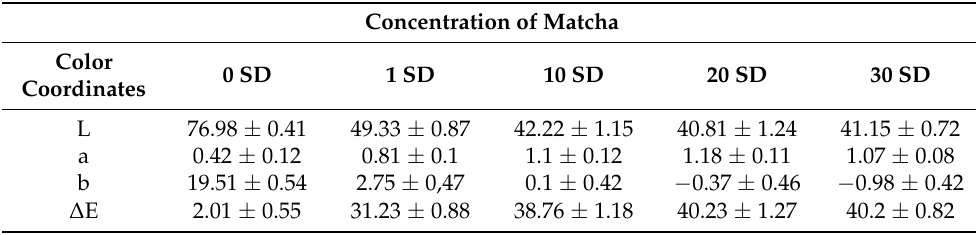
Figure 1. Box and whisker plot of color change ∆ E-value of dyed hair tresses with different concentrations of matcha in combination with 1 wt% iron(II)-lactate and the corresponding photographs of the hair tresses (n = 10). SE: standard error. Table 1. Color coordinates, L, a, b, and ∆ E of hair tresses dyed with different concentrations of